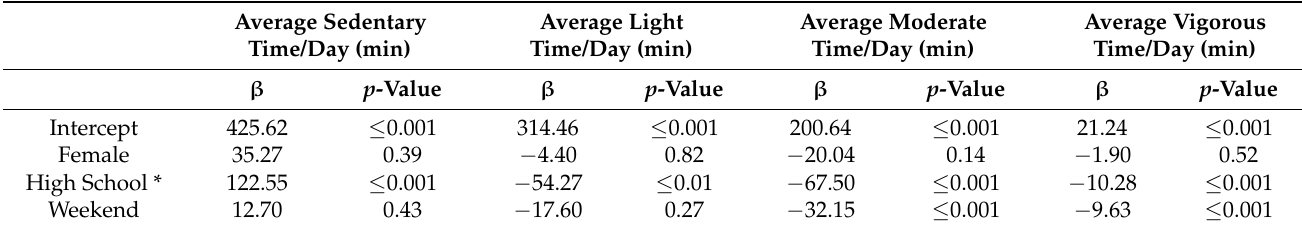
Table 4. Quantile linear mixed regression models of different PA activities adjusted by gender, grade, and